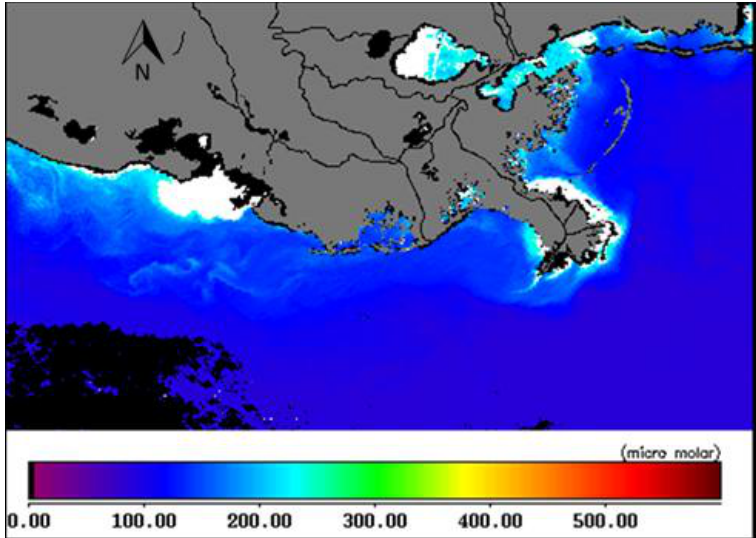
Figure 5. SeaWiFS-derived surface DOC concentration ( μ mol·C·L − 1 ) map for 6 February 2007. SeaWiFS-estimated DOC concentration higher than 250 μ M which are outside the regression of the SeaWiFS-estimated DOC vs. field DOC masked in white